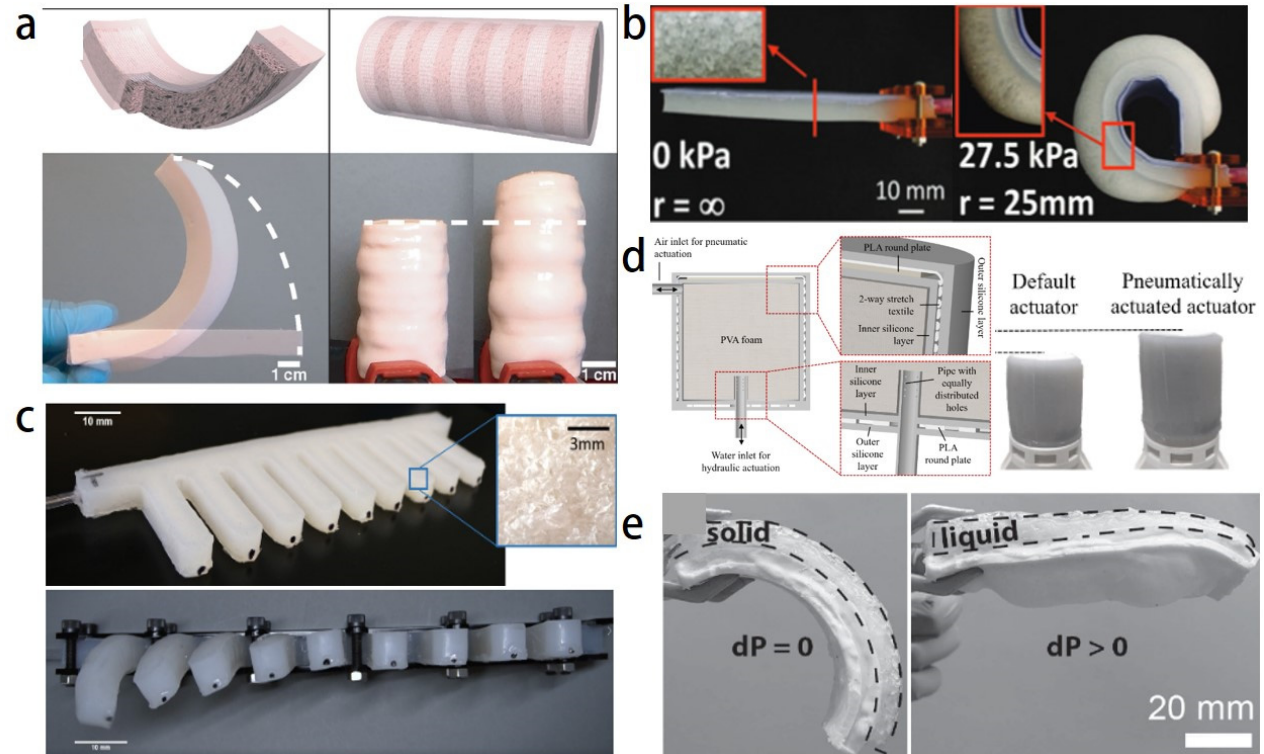
Figure 1. Soft foam actuators: ( a ) silicone foam bending actuator manufactured by the lost-salt process [28]; ( b ) silicone foam bending actuator [29]; ( c ) traveling wave-driven soft robot made of silicone foam that was inspired by a millipede [11]; ( d ) hybrid driven PVA foam actuator [30]; ( e ) composite foam actuator comprising a low-melting-point alloy and elastomer